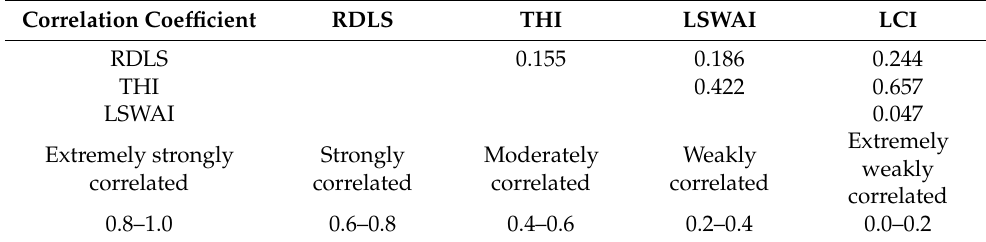
Table 2. Correlation coefficient matrix of the single HSS factors. Correlation Coefficient